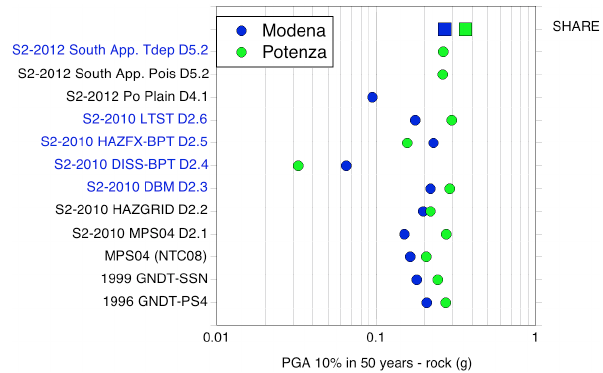
Figure 5. Comparison at two sites of expected PGA values (with 10% probability of exceedance in 50 years) from collected PSHA models (redrawn from Faccioli and Vanini, 2013). Modena is lo- cated in the Po Plain, at about 20–30km distance from the main earthquakes of the 2012 Emilia sequence; Potenza is at about 90km distance from the recursive sequences that affected the border of Calabria and Basilicata Regions, in southern Apennines, since 2011. Time-dependent models listed in this graph (labels in blue) have not been used in this